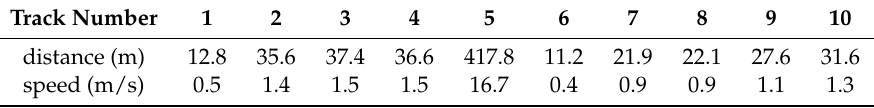
Table 4. Maximal Azimuth Moving Distance and Corresponding Azimuth Speed.